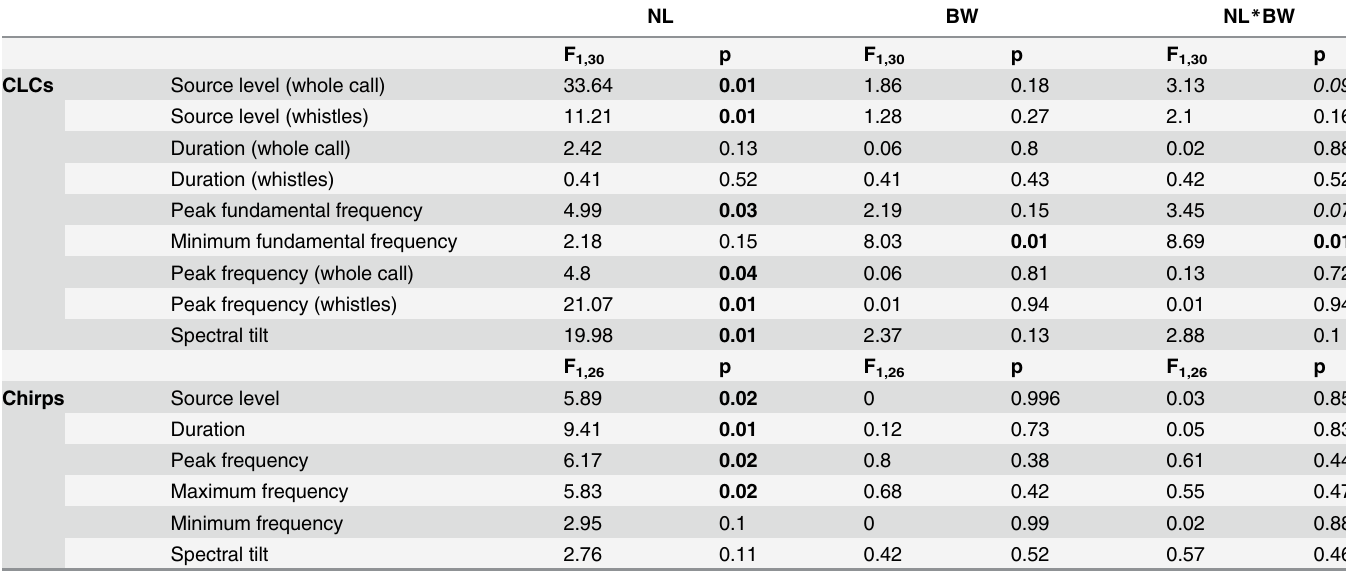
Maximum frequency Spectral tilt Noise playbacks included broadband (0.1 – 10 kHz) and narrowband (1.5 – 6.5 kHz) stimuli (Fig 2), at a range of amplitudes. Ambient noise (0.1 – 24 kHz) during control sessions was approximately 42 dB re 20 μ Pa rms, and the highest exposure level was approximately 66 dB re 20 μ Pa rms during treatment A (narrowband, high amplitude).